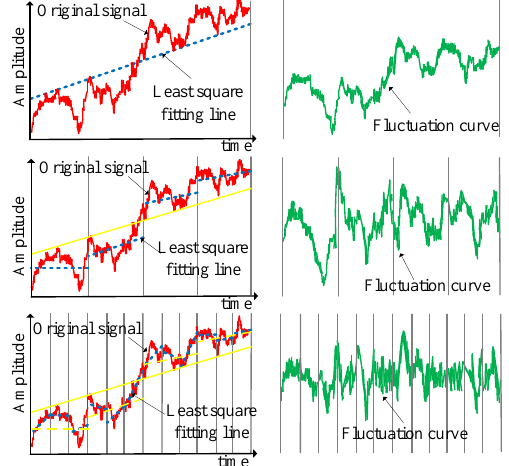
Figure 6. LS with different size of windows.